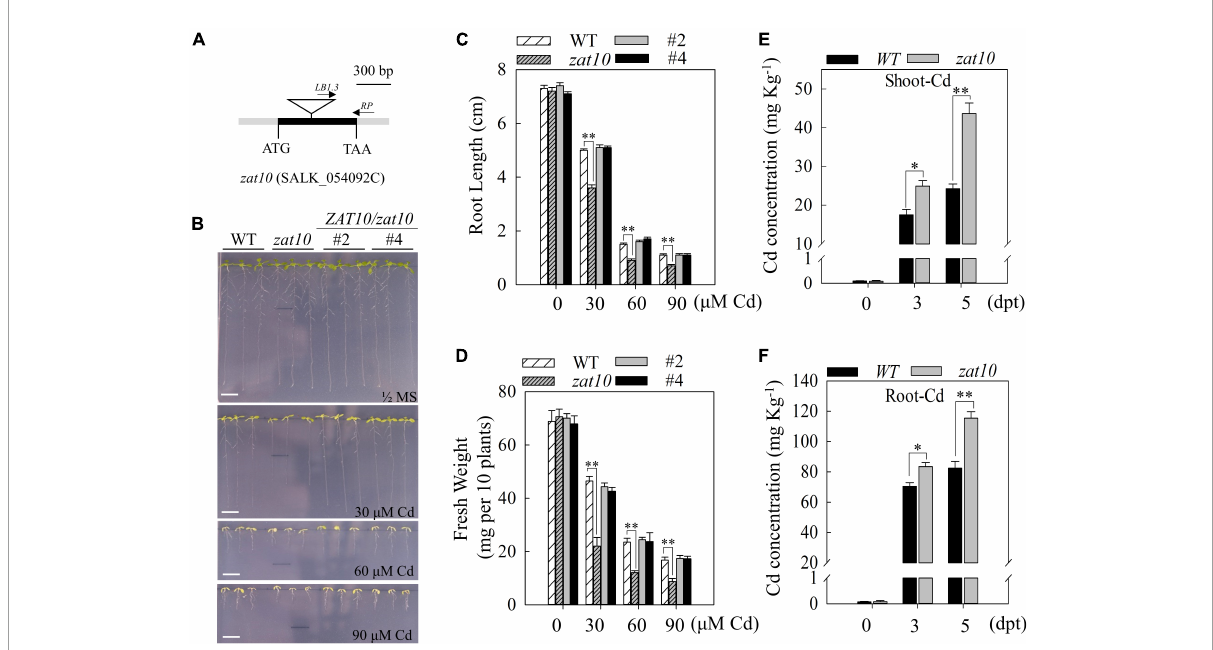
FIGURE2 The zat10 loss-of-function mutant is sensitive to Cadmium stress. (A) Schematic diagram of T-DNA insertion site on the locus of ZAT10 in the zat10 (SALK_054092C) mutant. (B) Phenotypic analysis of the wild type, zat10 mutant and ZAT10pro:ZAT10/zat10 complementary lines ( ZAT10/zat10 #2 , #4 ) under Cd stress. Nine-day-old seedlings grown on 1/2 MS medium without or with CdSO 4 (30, 60, and 90 µ M). Bar = 1 cm. Three independent experiments were done with similar results. (C,D) Root length (C) and fresh weight (D) of the wild type, zat10 mutant, and ZAT10/zat10 #2, #4 lines under the condition described in B. Means ± SD, n = 3; ∗∗ P < 0.01, Student’s t -test. (E,F) Cd concentration in shoot (E) and root (F) of the wild type and zat10 mutant under Cd stress. Seven-day-old seedlings grown on 1/2 MS medium were transferred to 1/2 MS medium without or with 30 µ M CdSO 4 for 0, 3, and 5 days. Means ± SD, n = 3; * P < 0.05 or **P < 0.01, Student’s t